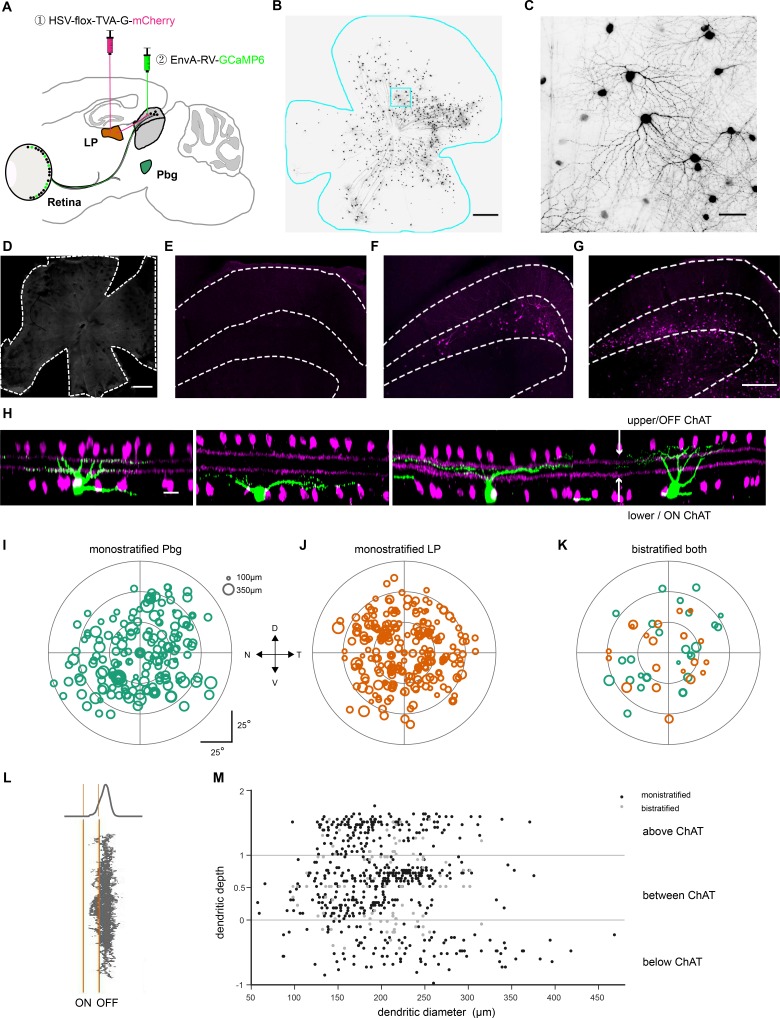
Viral tracing with EnvA-coated rabies virus and herpes-simplex-virus (HSV).(A) Injection strategy for labeling of the circuit connecting the retina to the pulvinar, via the superior colliculus. (B) Example retina with labeled ganglion cells innervating the colliculo-pulvinar circuit. Scale bar = 500 μm. (C) Zoomed-in version of B. Scale bar = 50 μm. (D) Whole-mount retina stained with antibody for GCaMP6s after EnvA-coated SAD-△G-GCaMP6s rabies virus injection to superior colliculus alone without first injection of HSV. No labeled cells are observed 11 days after injection. Scale bar: 500 µm. (E) Injection of conditional HSV into the pulvinar of a wild-type mouse without any Rabies injection. Very few labeled cells are observed 21 days after injection. (F–G) Injection of conditional HSV into the pulvinar (F) and non-conditional HSV into the parabigeminal nuclei (G) labeled superior colliculus neurons. Neurons were stained with anti-mCherry antibody, showed in magenta. Scale bar = 200 µm. (H) Side-view of z-stack scans of four example retinal ganglion cells (green) and the ChAT-bands (magenta). Scale bar = 20 µm. (I–K) Retinal position and dendritic tree diameter of retinal ganglion cells that are part of the colliculo-parabigeminal circuit (I), cells innervating the colliculo-pulvinar circuit (J), and bistratified ganglion cells of both circuits (K). To determine if the differences in size between the colliculo-parabigeminal and colliculo-pulvinar circuit are due to a bias in the retinotopic location of the sampled ganglion cells, we analyzed the spatial distribution of the labeled neurons across the retina. For each circuit, we sampled evenly from each retinal quadrant (15.6% naso-dorsal, 30.4% dorso-temporal, 28.3% temporo-ventral, 24.6% ventro-nasal. In addition, we sampled at all retinal eccentricities: 52% of labeled ganglion cells were sampled from the central third of the retina (within 30° of the optic nerve), 43% from the middle third (30°−60° from the optic nerve) and 5% from the peripheral third (60°−90° from the optic nerve). This indicates that the observed difference in size between the two circuits is not due to a sampling bias in retinotopic location. N = nasal, D = dorsal, T = temporal, V = ventral. The optic nerve is indicated with a black disc. (L) The distribution of the dendritic tree in depth was summed to create a stratification profile. (M) Stratification depth and dendritic tree diameter of all 658 labeled retinal ganglion cells from both experimental conditions.